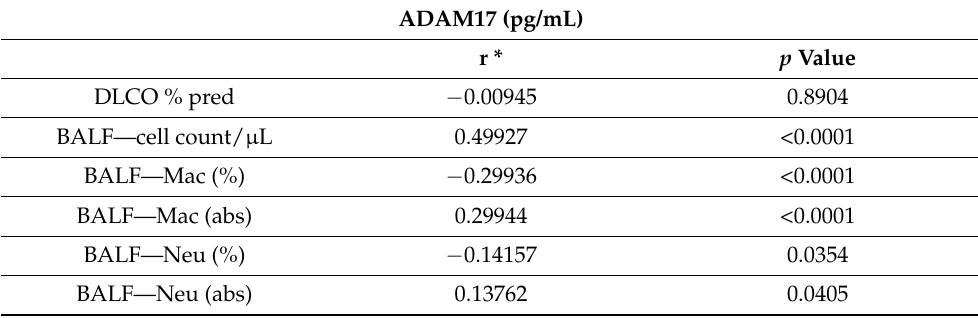
Table 4. Correlation analysis of ADAM17 with cell count in BALF and with DLCO (all study